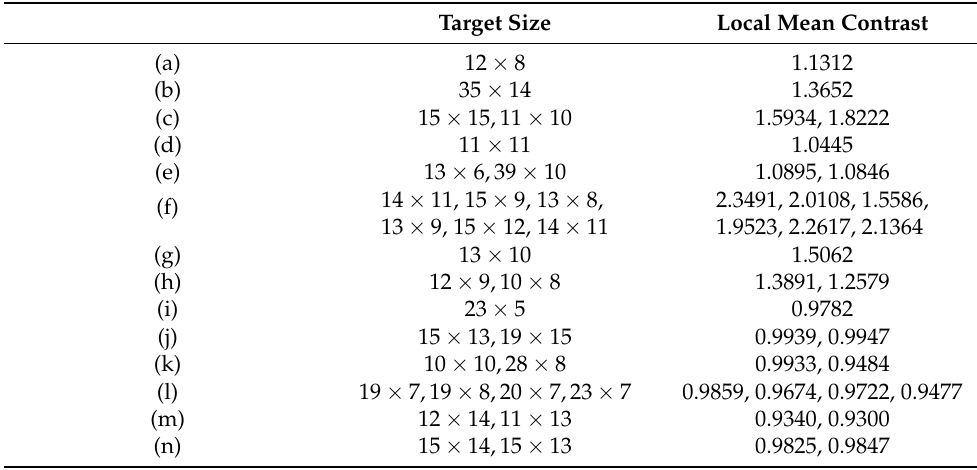
Figure 7. Typical single frame images of 14 different scenes. ( a – n ) represents the image of a certain type of scene respectively. Table 2. Detail information contained in 14 different